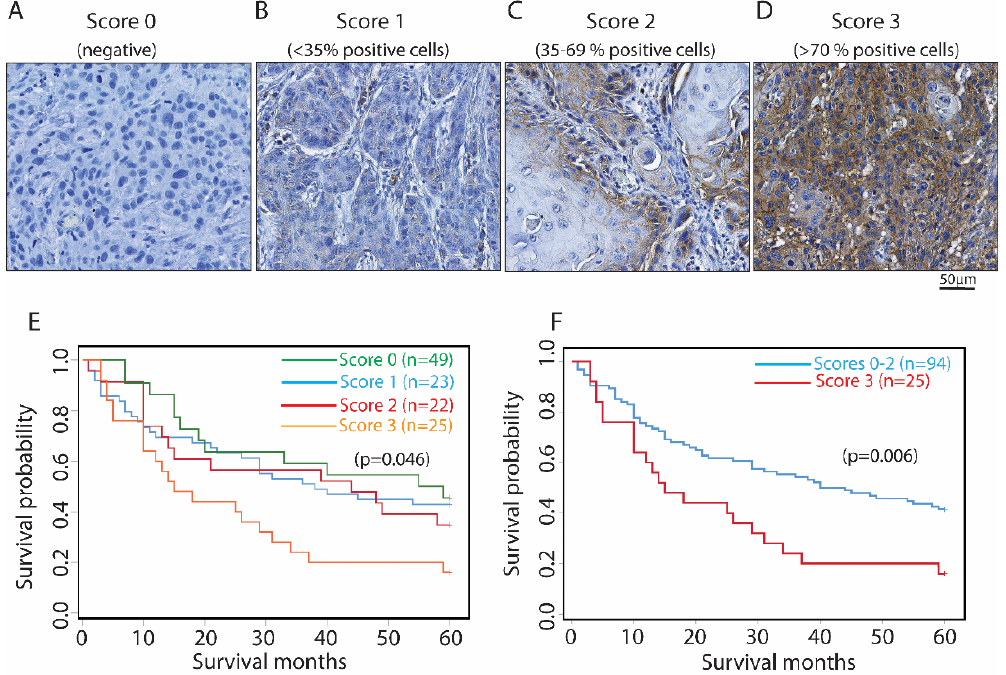
Figure 4. Higher HPA008999 immunoreactivity at tumor center was associated with poorer 5 year- overall survival of OSCC patients. ( A – D ) Representative images showing different HPA008999 immunoreactivity scores at the tumor center of OSCC lesions. Kaplan – Meier plots demonstrating poorer 5-year overall survival probabilities for OSCC with score 3 as compared to the scores 0–2 ( E ) and score 3 as compared to rest of the scores combined ( F ). Log-Rank test was used for statistical analysis.